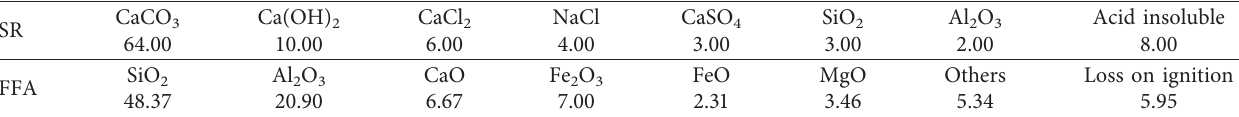
Table 3: The chemical compositions of soda residue (SR) and F class fly ash (FFA) by XRF test. Loss on ignition refers to the mass loss on ignition at 1000 ° C (wt.%).